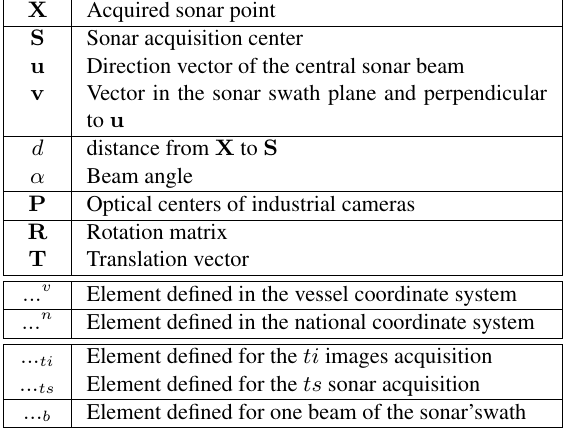
Table 1. Chart of the notations used in this section.